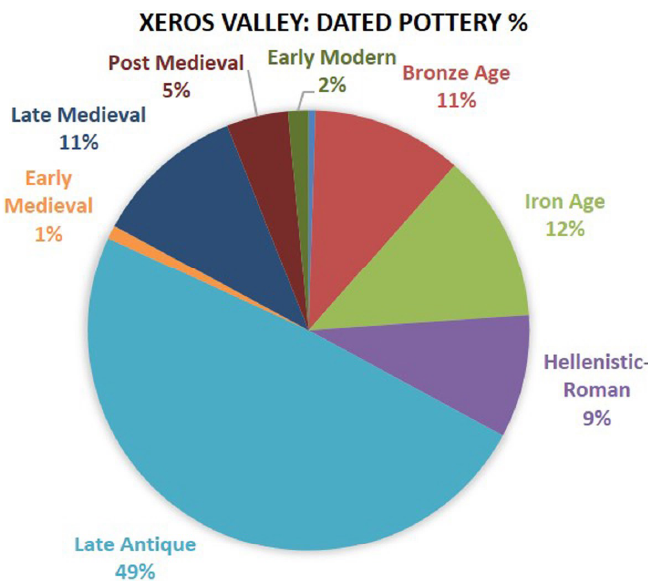
Figure 23. The percentages of dated pottery from sites in the Xeros River valley (Graph by Athanasios K.